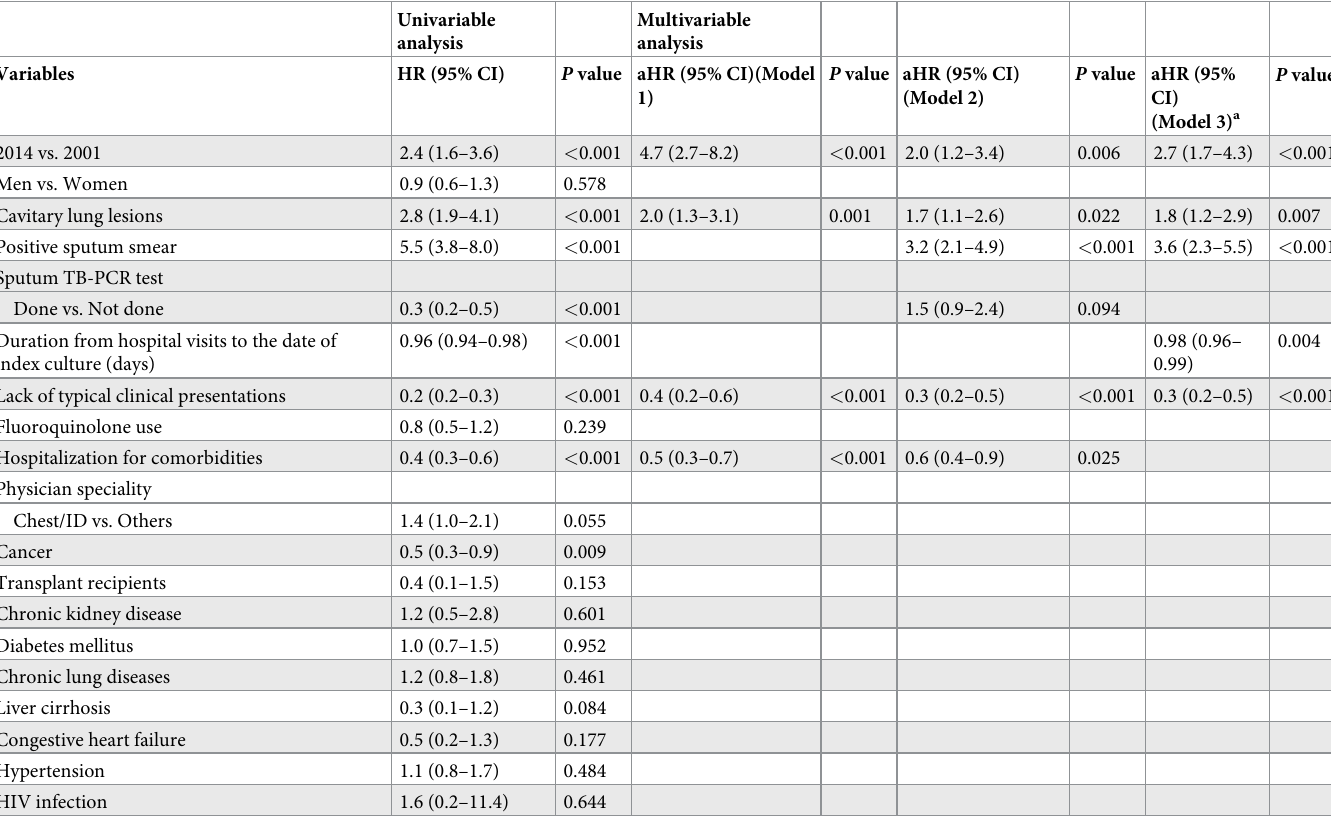
Table 2. Factors associated with prompt respiratory isolation (Model 1: 2014 vs. 2001; Model 2: The effects of positive sputum acid-fast smear and TB-PCR; Model 3: The effect of physician